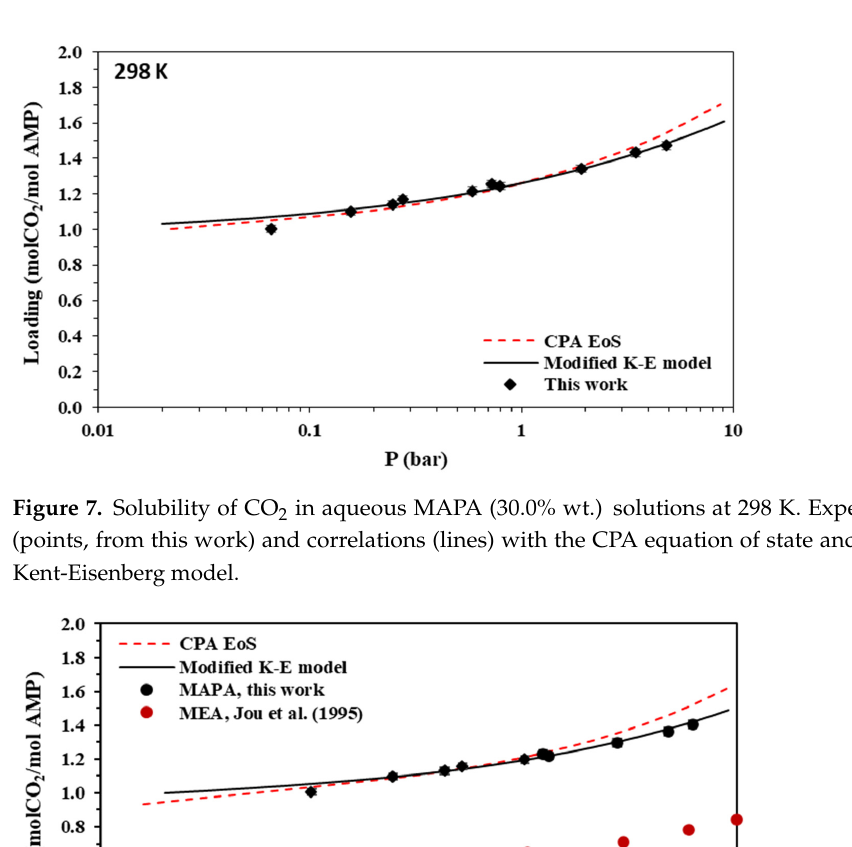
Figure 6. Solubility of CO 2 in aqueous AMP (17.7% wt.) solutions at 333 K. Experimental data (points, from this work and Tontiwachwuthikul et al. [31]) and correlations (lines) with the CPA equation of state and the modified Kent–Eisenberg model.